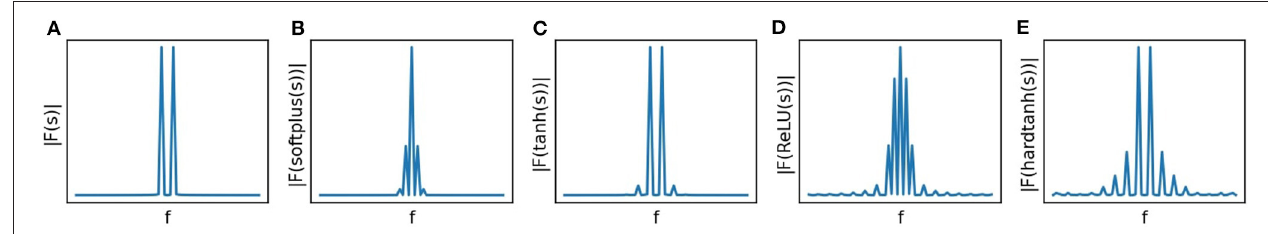
FIGURE 1 | Non-linear distortions in the frequency domain due to the application of (B) softplus, (C) tanh, (D) ReLU, and (E) hardtanh non-linear activations on s ( · ) = sin( · ) (A)